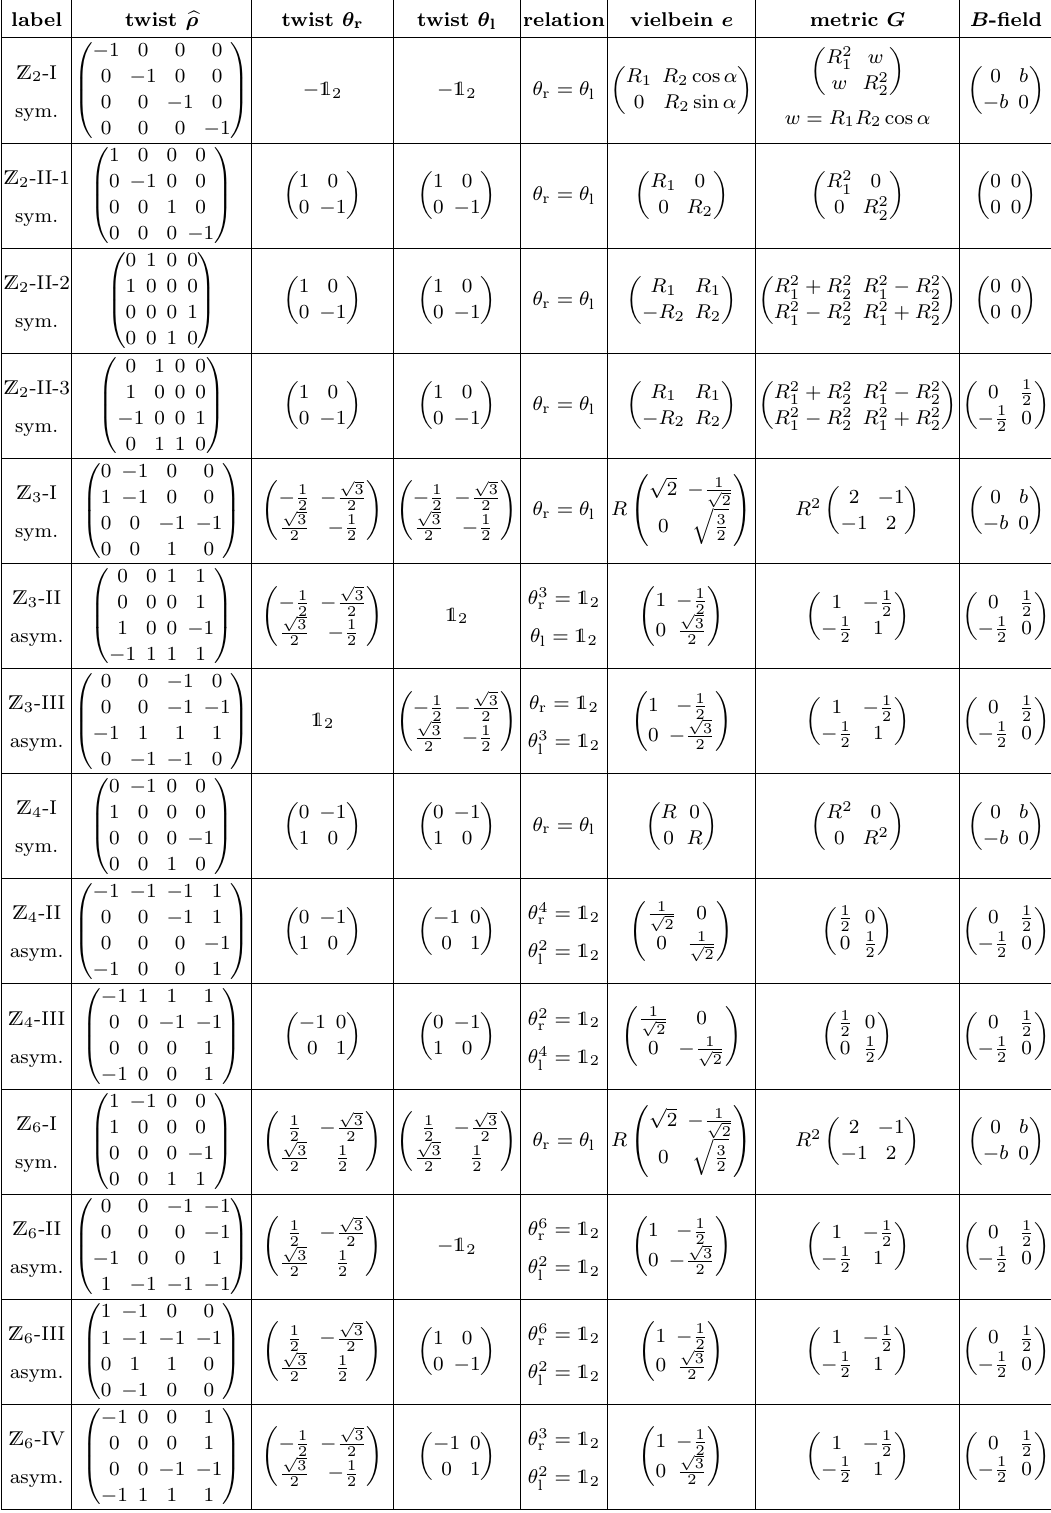
twist (cid:18) r twist (cid:18) l relation vielbein e metric